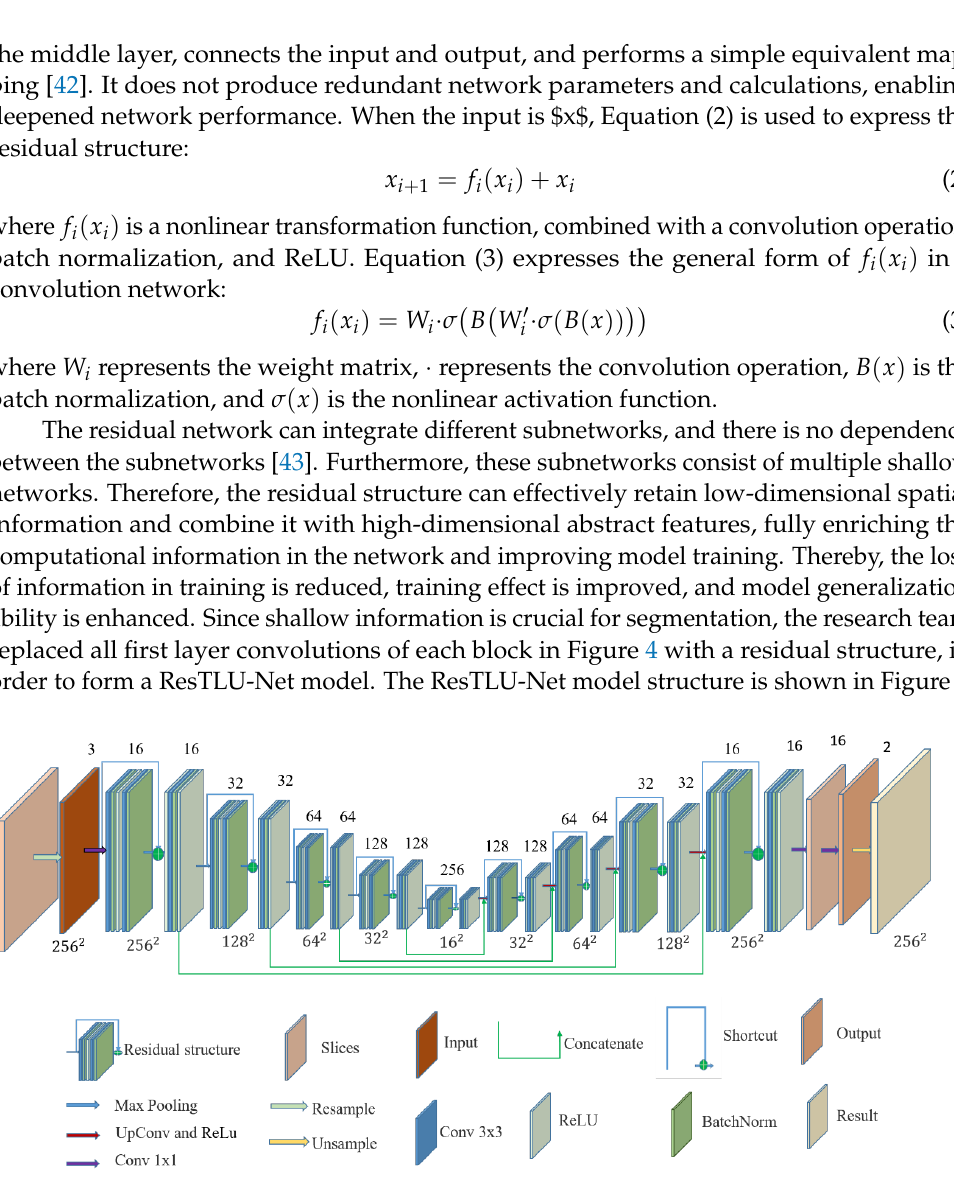
Figure 5. ResTLU-Net, constructed by adding a U-Net residual structure.